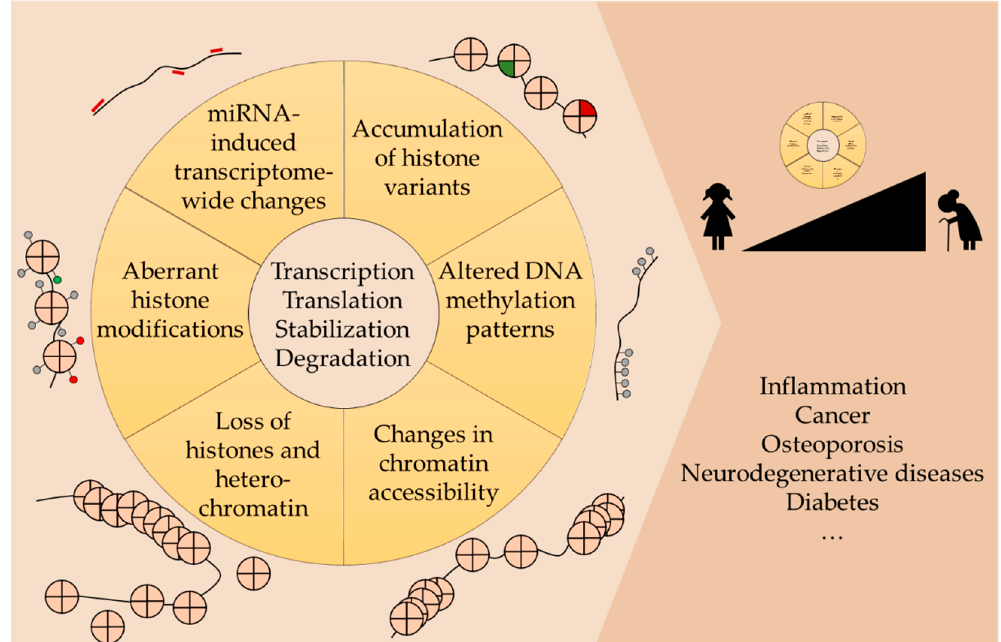
Figure 1. Epigenetics of aging and aging-related diseases. During aging, various epigenetic alterations occur including accumulation of histone variants, changes in chromatin accessibility mediated by chromatin remodeling complexes, loss of histones and heterochromatin, imbalance of activating/repressing histone modifications and aberrant expression/activity of miRNAs. These deregulations can affect transcription and, subsequently, translation, as well as the stabilization or degradation of molecular components. Consequently, these aberrant epigenetic processes can promote morbidities, which are frequently observed in the elderly populations, including inflammation, cancer, osteoporosis, neurodegenerative diseases, and diabetes.